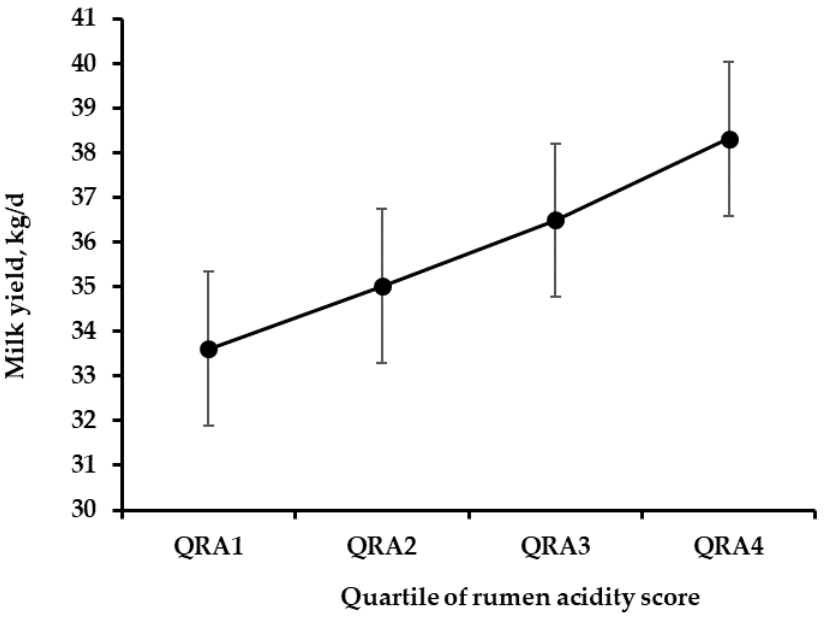
Figure 2. Effect of the quartile of rumen acidity score (QRA1, greatest rumen acidity, to QRA4, lowest rumen acidity) on milk yield ( p of the linear component: < 0.03). Table 4 . Effect of the quartile of rumen acidity score (QRA1, greatest rumen acidity, to QRA4, lowest rumen acidity) on the body condition score (BCS) and milk composition of Holstein cows.